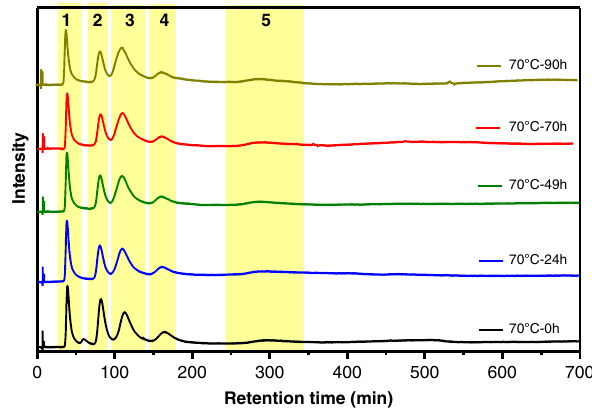
Fig. 2 Exemplary HPL chromatograms for deracemization